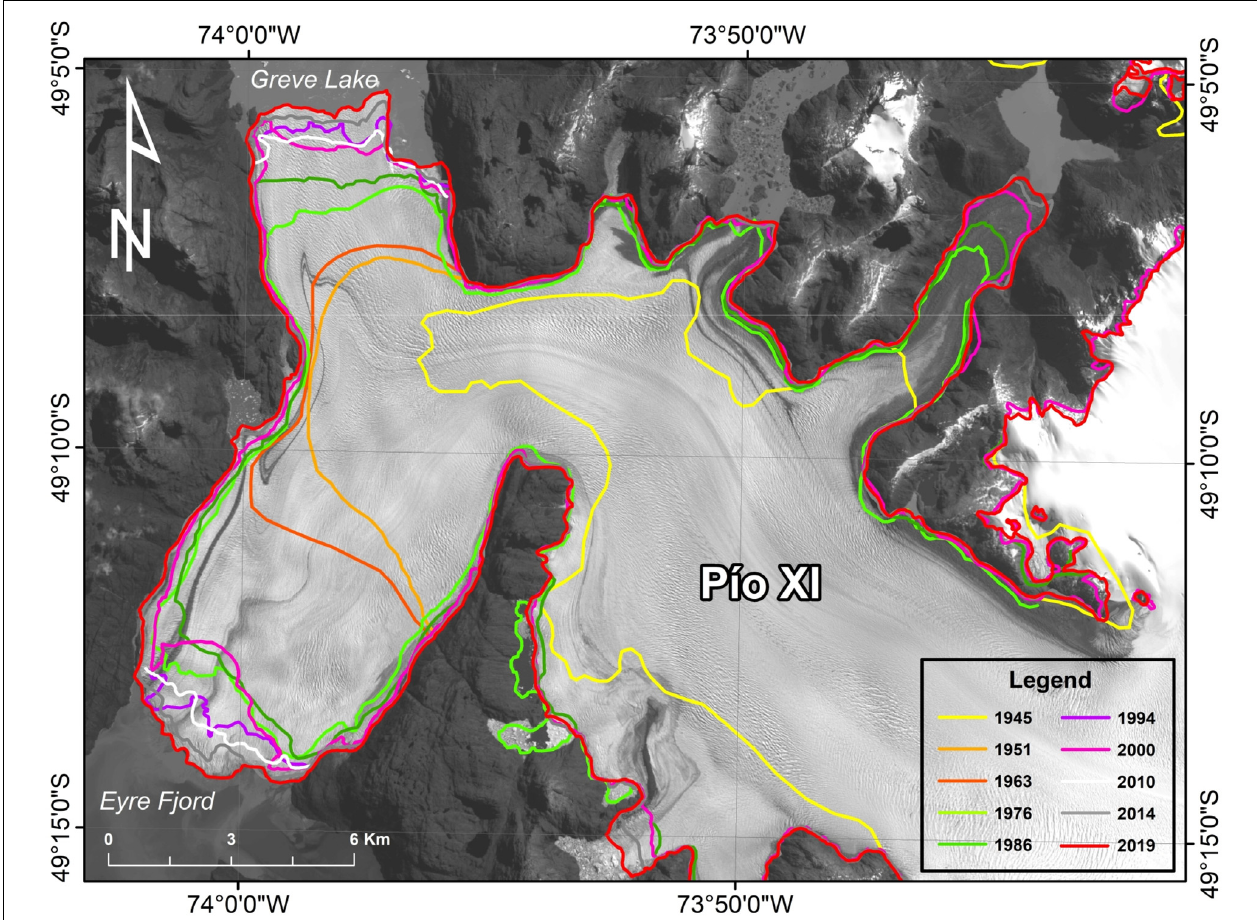
FIGURE 9 | Changes in surface area of Pío XI glacier between 1945 and 2019. This glacier is the largest outlet glacier of the SPI and unlike most of the glaciers in the region, it has shown an anomalous behavior with an advancing front over most of the last century. Sources: Available aerial photographs and satellite